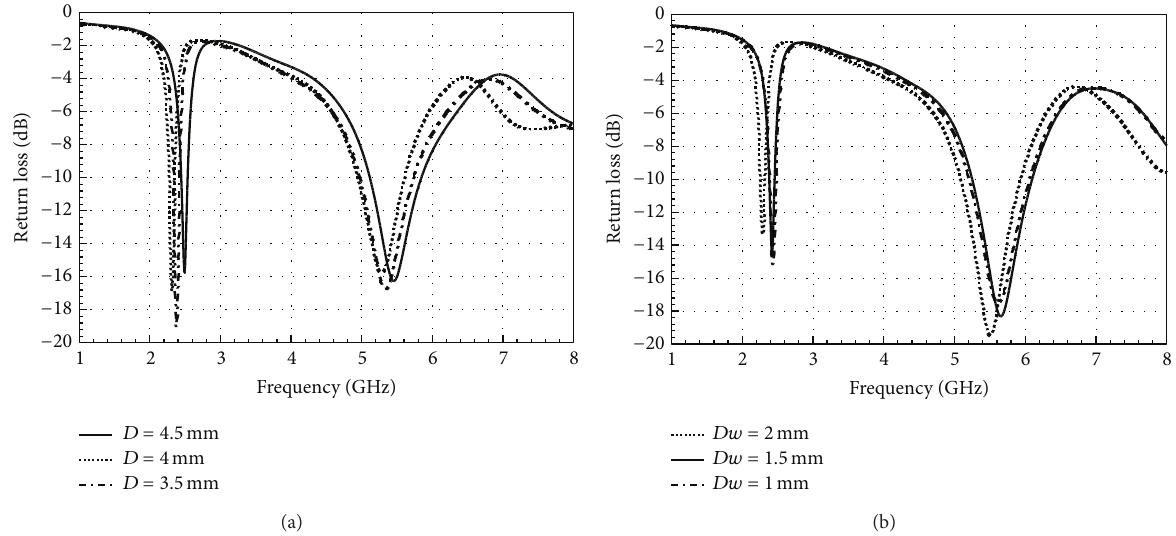
Figure 6: Simulation results by tuned parameters to the distance between (a) feeding and shorting plate. (b) DGS and inverted-e-shaped edge.